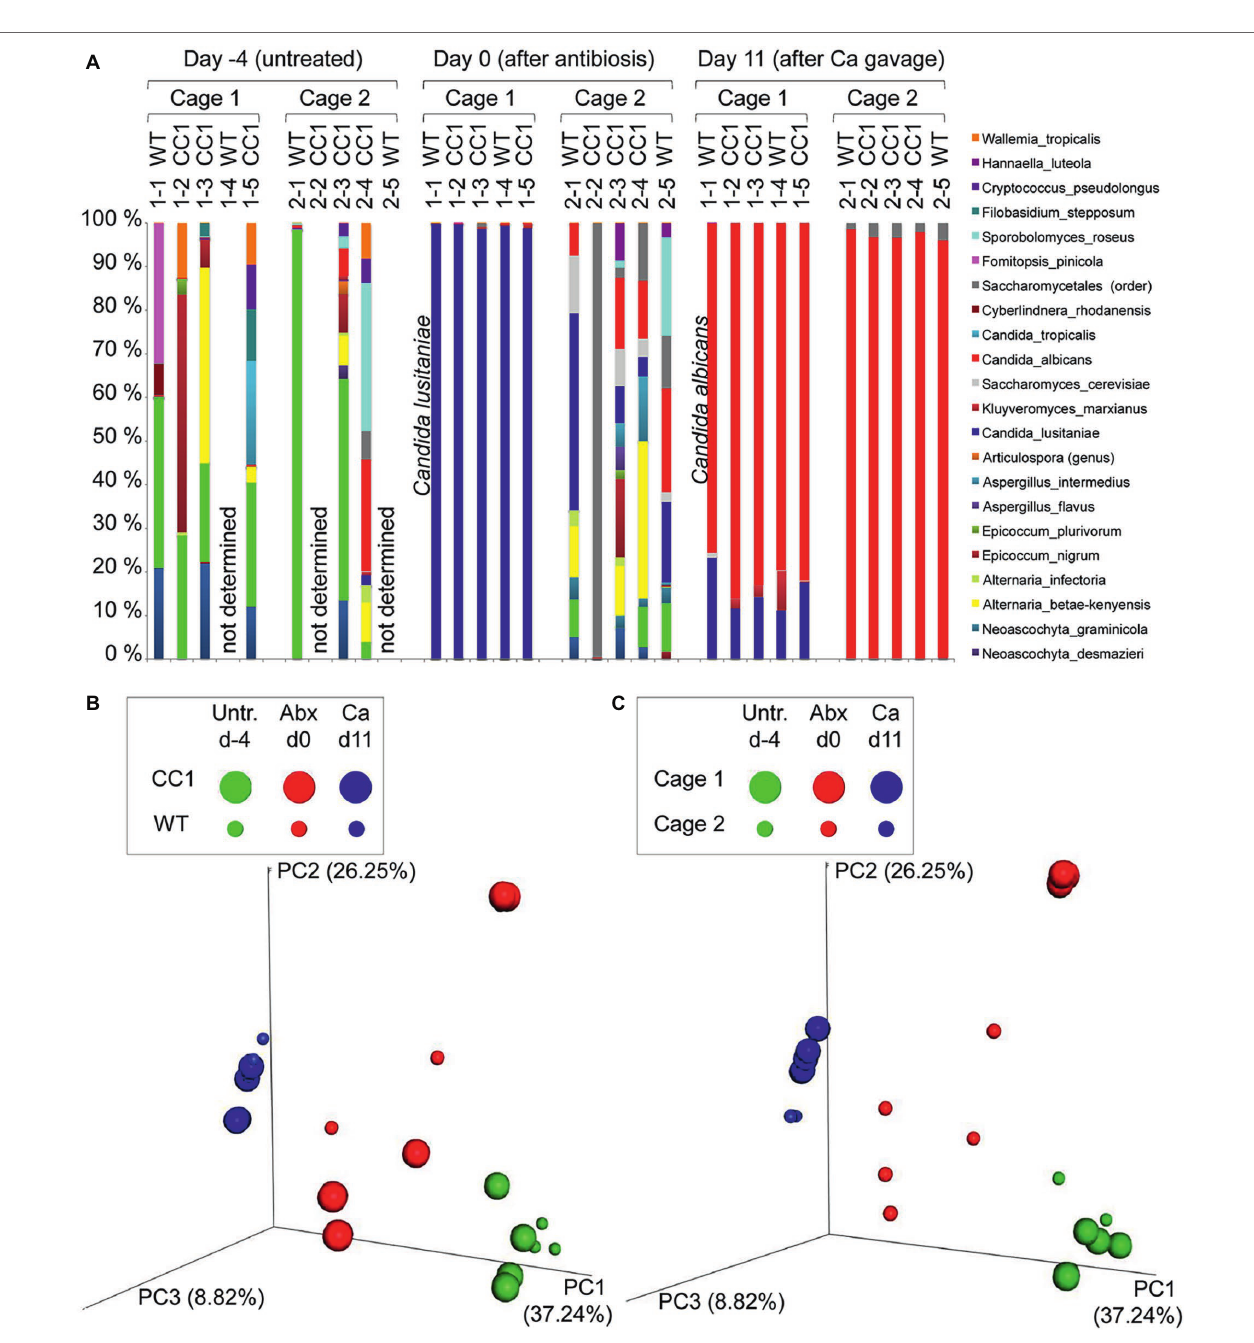
FIGURE 2 | Co-housing, but not the expression of human CEACAM1 influences the fungal beta diversities in a C. albicans colonization model. DNA samples studied in Figure 1 were analyzed for fungal species by ITS sequencing. Human CEACAM1-transgenic mice (CC1, N = 5) and their wild-type littermates (WT, N = 5), co-housed in two cages, were treated with antibiotics from day −4 and inoculated with 5 × 10 7 CFU C. albicans orally at day 0 (see also Table 1 ). Feces were collected from individual mice on day −4 (untreated = before antibiotic treatment), day 0 (4 days of antibiosis/before C. albicans inoculation), and day 11 (11 days of C. albicans inoculation, continuous antibiosis). Note that for three samples (labeled as “not determined”) not enough feces was left for this analysis, since the samples were necessary to determine the primary effect size (fungal colonization) shown in Figure 3A . (A) Bar plots of operational taxonomic units (OTUs) detected in fecal samples with a minimum relative abundance of 0.1% of all detected OTUs in at least one sample. See also Supplementary Tables S1–3 for a list of the species detected with a minimum occurrence of 0.1% in at least one sample and their relative abundance in all samples. (B,C) PCoA plots of calculated Bray- Curtis distances (beta diversities) of fungal species between all samples were generated and subsequently analyzed for the similarity (ANOSIM) between different sample groups: (B) WT vs. CC1 and (C) cage 1 vs. cage 2 in untreated mice (Untr., day −4), after antibiosis (Abx, day 0), and after oral C. albicans inoculation (Ca, day 11). Statistical results of comparisons between groups are given in the text. All data are from one single experiment. (See also Supplementary Figure S1A for alpha diversity/Shannon